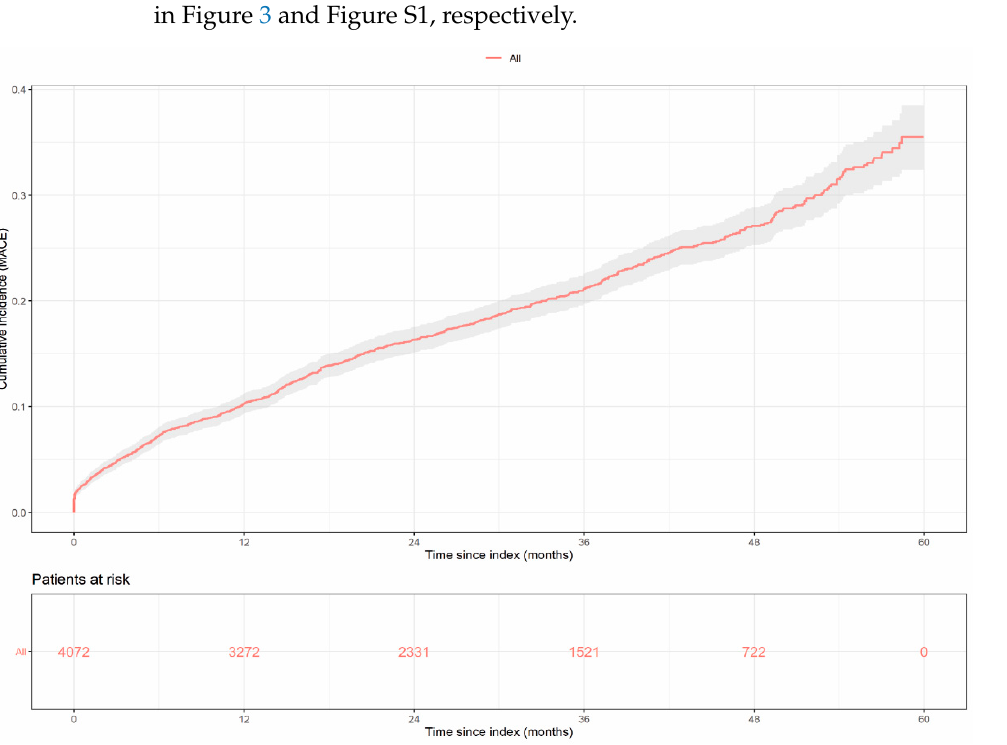
Figure 3. Cumulative incidence of MACE over time during the follow-up period. Probability of any new MACE (myocardial infarction, stroke, unstable angina, and urgent revascularization) is shown. The number of patients at risk across the follow-up period is indicated below.